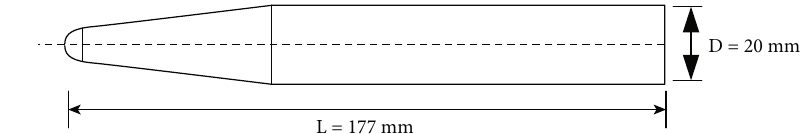
Figure 8: A sketch of the test model.